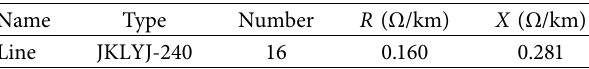
Table 1: Line information.